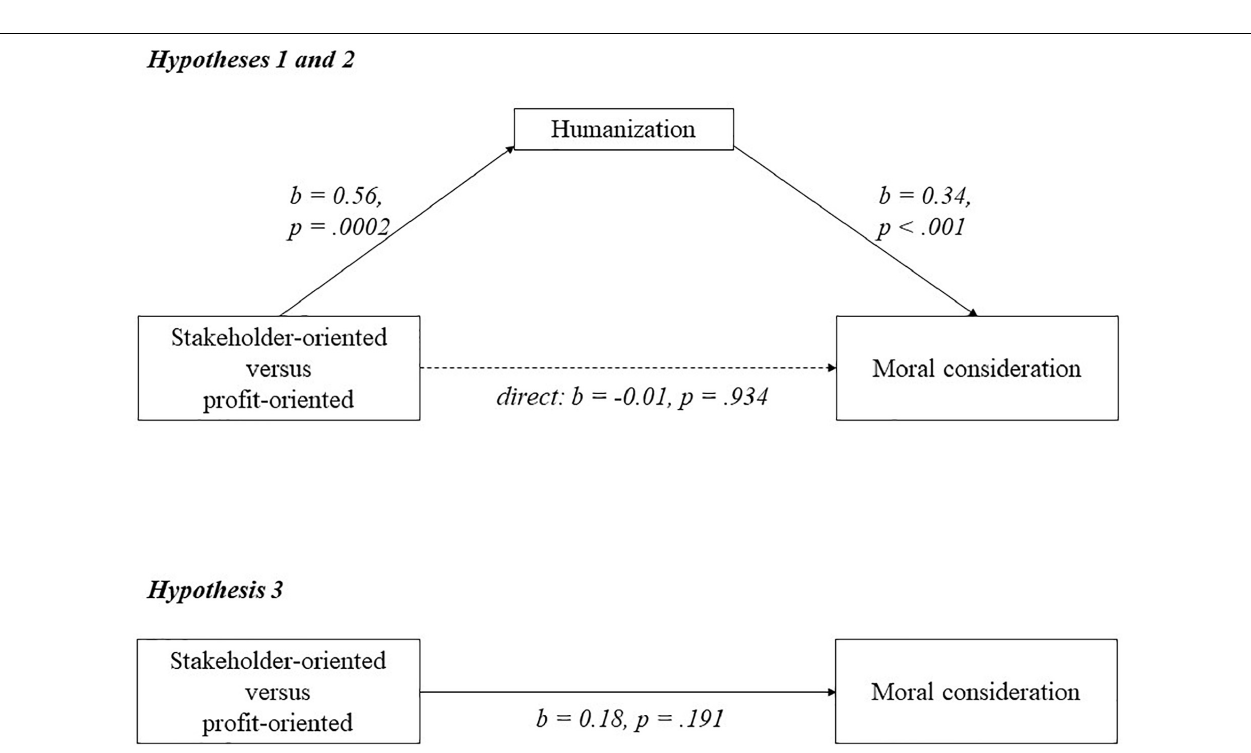
FIGURE 2 | A model of mediation indicating that the relationship between business orientation and moral consideration goes via humanization in experiment 3.